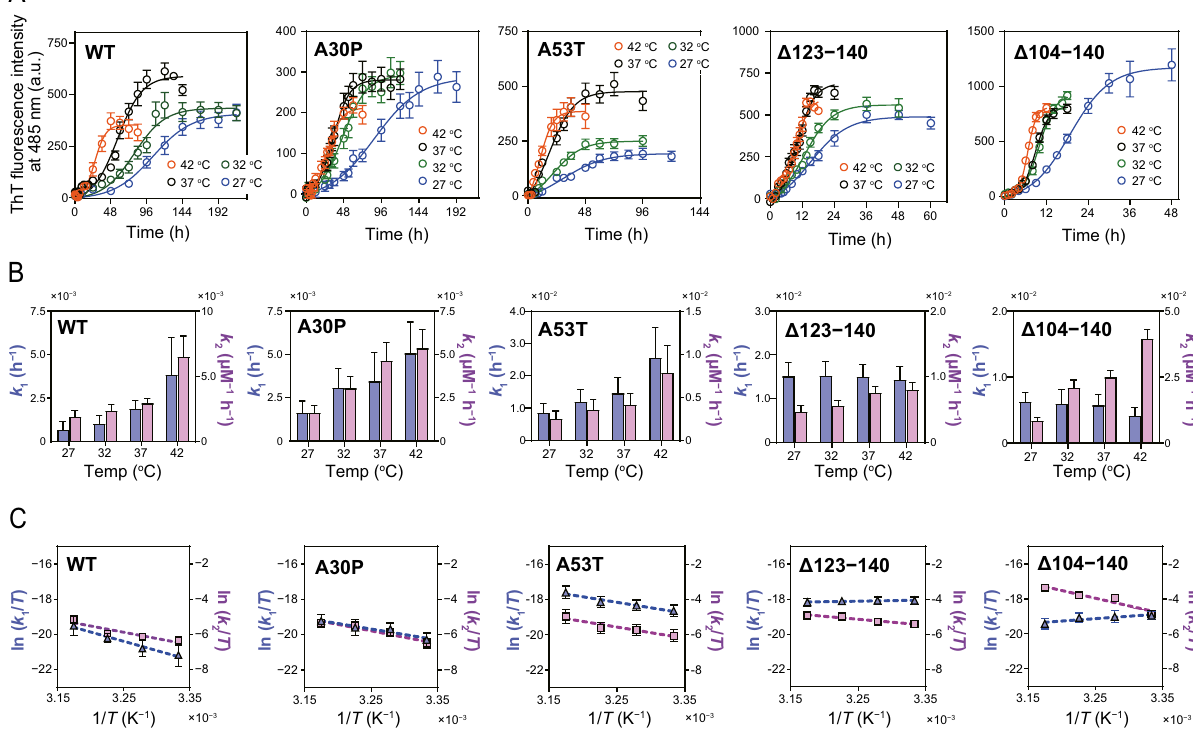
Figure 7. Temperature dependence of fibril formation kinetics of α-syn variants. ( A ) ThT fluorescence curves for fibril formation of α-syn at varying temperature. Each experiment was repeated at least triplicated. Error bars represent S.E. ( B ) Temperature dependencies of rate constants for nucleation ( k 1 , light blue) and fibril growth ( k 2 , light purple) for fibril formation of α-syn variants. The rate constants were determined according to the Finke–Watzky 2-step model. Error bars represent S.E. ( C ) Eyring plots of rate constants of k 1 and k 2 for fibril formation. Error bars represent S.E. The dashed lines represent linear regression lines. Nucleation, k